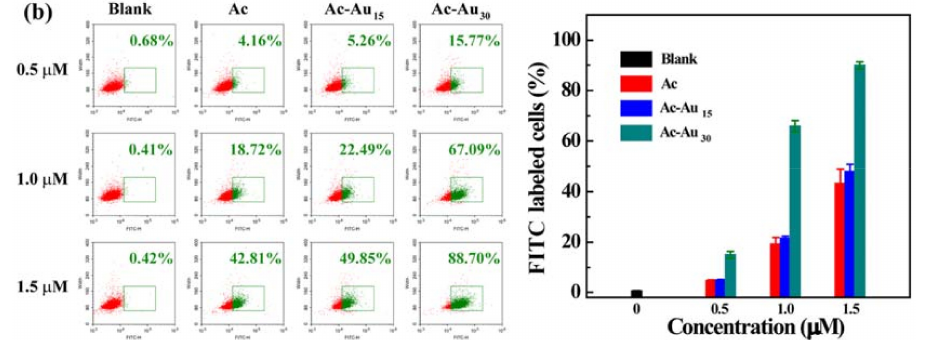
Figure 4. Flow cytometry analysis of U87MG cells after treatment with Ac, Ac-Au 15 , Ac-Au 30 dendrimers for 3 h ( a ) and 6 h ( b ).